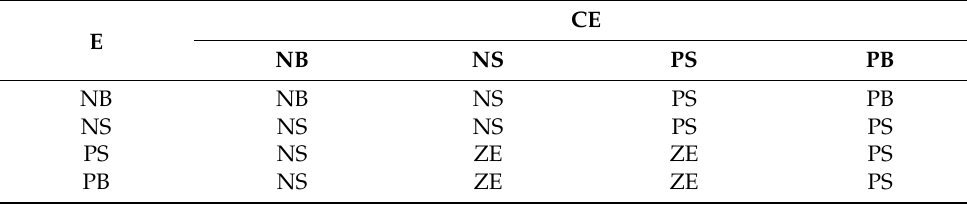
Table 6. Fuzzy rules for the wind turbine.